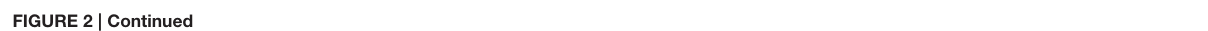
Frontiers in Cell and Developmental Biology |